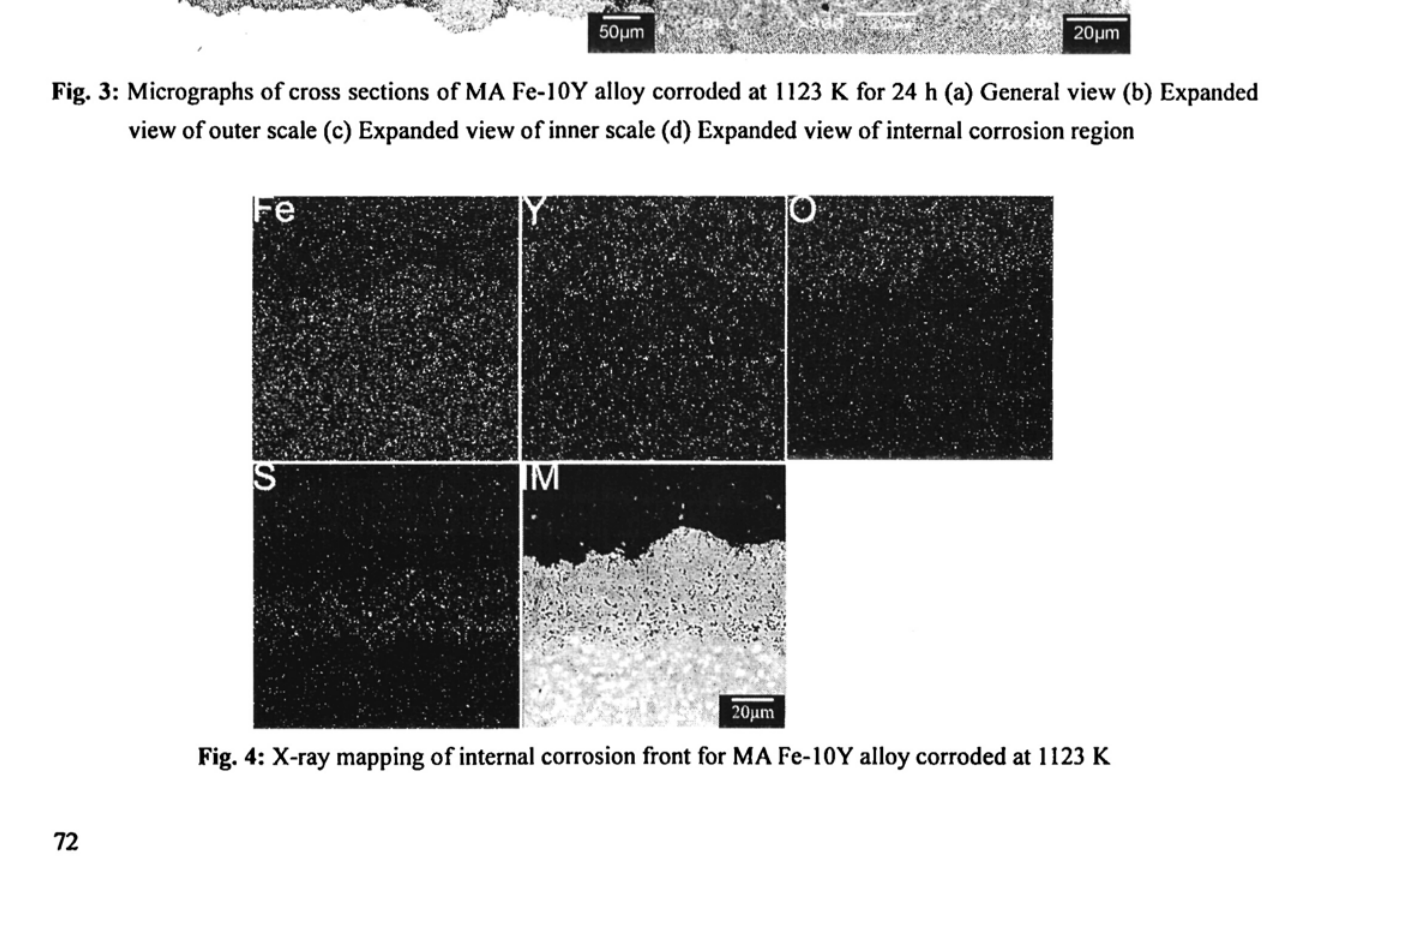
Fig. 4: X-ray mapping of internal corrosion front for MA Fe-10Y alloy corroded at 1123